Question: Summarize what this figure shows in one sentence.
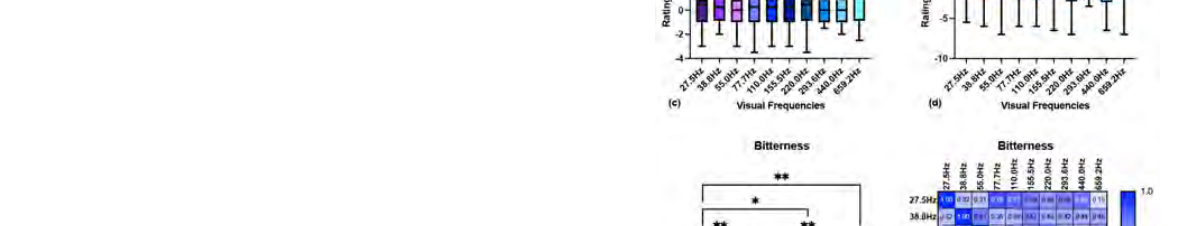
Answer: The process of user study 1